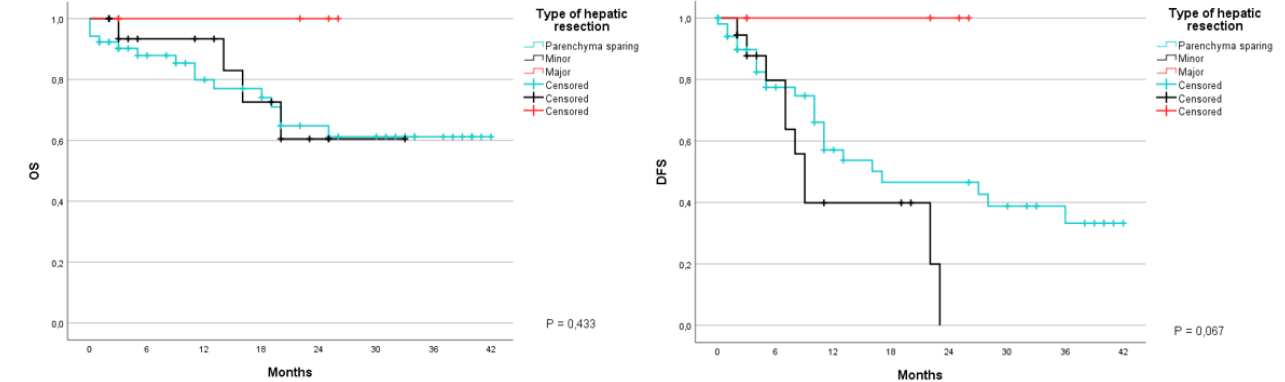
Figure 8. Kaplan-Meier Curve for OS and DFS in patients who underwent liver resection for CRLM stratified according to type of hepatic resection. OS: Overall Survival; DFS: Disease Free Survival; CRLM: Colorectal liver metastasis.